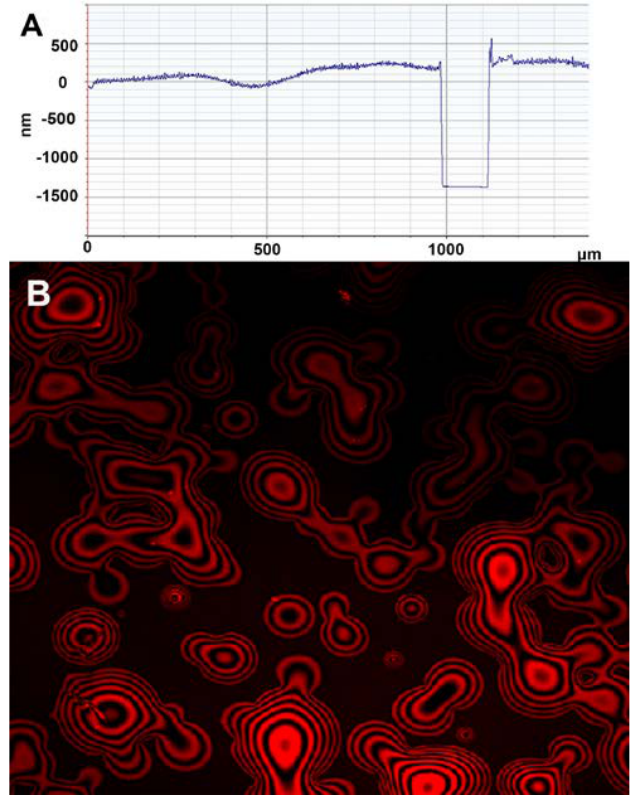
Figure 4. Step profile ( A ) and horizontal cross-section graph ( B ) of PFMA dielectric layer.